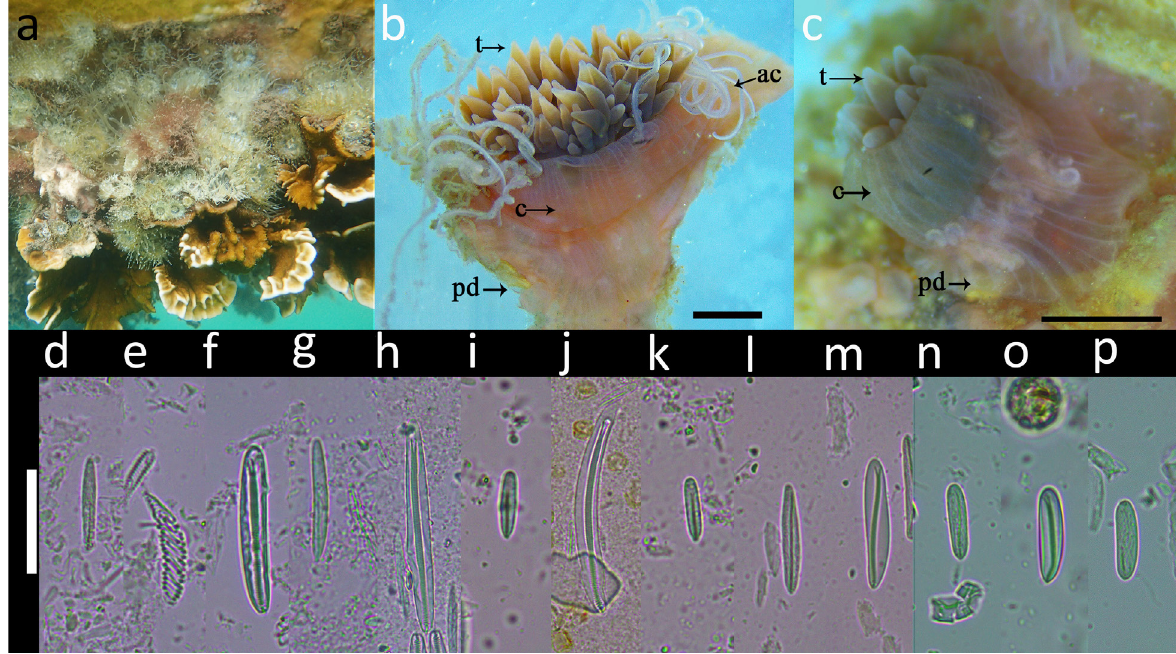
Figure 5. Exaiptasia diaphana (Rapp, 1829). a live specimen in natural habitat. b lateral view. c young anemone on the adult column (b). d-p Cnidae. – tentacle: d basitrich e spirocyst f microbasic p -amastigophore; acontia: g basitrich h large microbasic p -amastigophore; filament: i basitrich j large microbasic p -amastigophore k microbasic p -amastigophore; actinopharynx: l basitrich m microbasic p -amastigophore; column: n basitrich o microbasic p -amastigophore p microbasic b -mastigophore. Abbreviations. –ac: acontia, c: column, t: tentacle, pd: pedal disc. Scale bars: b: 2 mm; c: 1 mm; d-g, i, k-p: 20 µm; h, j: 30